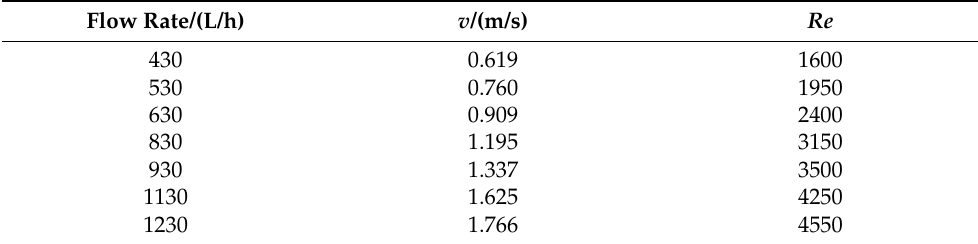
Table 1. Overview of the studied flow rates, fluid velocities and the relevant Re values. Flow Rate/(L/h)